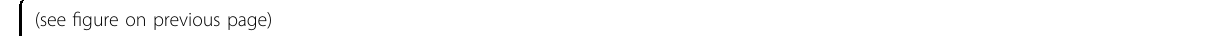
Fig. 2 Hypermethylation of the SatIII DNA locus by D-TALES diminishes SatIII RNA expression and increases sensitivity towards etoposide. A Schematic representation of SatIII DNA locus with all CpG localizations (red) as well as the TALE-binding sites (green). B Representative images of the co-localization of TALE-GFP (green) and SatIII RNA (red). HeLa cells were transfected with the TALE-GFP construct and exposed to HS conditions (1 h at 44 °C) 24 h after transfection in order to induce SatIII RNA expression and foci accumulation. Cells were fi xed, immunostained, and imaged. The histogram indicates co-localizations, represented by overlapping peaks of fl uorescence intensities. C Methylation level of the SatIII DNA locus in D- TALEa (active) and D-TALEi (inactive vector control) transfected U2OS cells. At 24 h and 48 h post-transfection U2OS cells were exposed to 44 °C for 1 h (HS) conditions and harvested. Cells were FACS-sorted and mCherry positive cells used for DNA extraction and subsequent pyrosequencing of the SatIII DNA locus. Shown is the percent of methylation to a transfection control. D Quantitative PCR analyses for SatIII RNA expression of samples from ( C ). Samples incubated for 48 h with the transfection mix were used. Error bars represent standard deviation of the mean of two individual replicates. E Drug response of U2OS cells either transfected with D-TALEa or an inactive control plasmid (D-TALEi). Viabilities were examined by AlamarBlue. Error bars represent standard deviation of the mean of three replicates. Two-tailed paired Student ’ s t test signi fi cant P -values are marked: < 0.05 with (*), < 0.01 with (**), < 0.001 with (***). F Caspase-3/-7 assay of U2OS cells either transfected with the D-TALEa plasmid or an inactive control (D-TALEi). At 24 h post-transfection, cells were treated with different concentrations of etoposide or a DMSO control for 24 h. Depicted are the differences of blue fl uorescence (BFU) signals between D-TALEa and D-TALEi. Error bars represent standard deviation of the mean of the three replicates. Two-tailed paired Student ’ s t -test signi fi cant P -values are marked: < 0.05 with (*), < 0.01 with (**), < 0.001 with (***). G Cell viability of HCC827 cells stably expressing either shRNA which targets SatIII (shSatIII, blue) or a shGFP-Control (red). Cells were exposed to 44 °C for 1 h (HS) and afterwards immediately treated with the indicated etoposide concentrations. After an additional 48 h cell viability was measured using